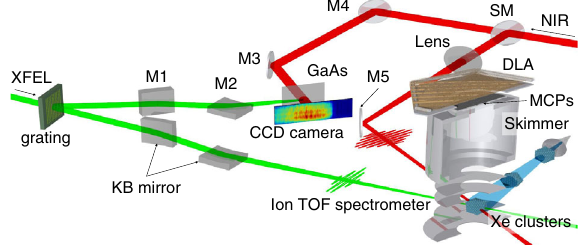
FIG. 3. Schematic picture of the XFEL-pump – NIR-probe experiment. The incident XFEL pulse impinges the grating [34], which generates multiple beams. A main part of the XFEL beam is focused on the interaction point by Kirkpatrick-Baez (KB) mirrors. The XFEL pulse [5.5 keV, < 10 fs (FWHM), 30 μ J = μ m 2 ] and the NIR laser pulse [800 nm, 32 fs (FWHM), 15 nJ = μ m 2 ] illuminate the Xe clusters ( h N i ¼ 5000 atoms) directed to the interaction point through a skimmer. The ion time-of-flight (TOF) spectrometer accelerates the produced ions, and the position sensitive detector, constructed with microchan- nel plates (MCPs) and a delay-line anode (DLA), detects them. The different ion charges are clearly separated in the time-of- flight spectra. The other parts of the XFEL and NIR laser illuminate single crystals from gallium arsenide (GaAs) serving as targets for the arrival timing monitor [34]. The CCD camera records the spatial modulation of the optical transmittance of the NIR laser in order to determine the accurate time delay of the NIR-probe pulse with respect to the XFEL-pump pulse. M1 and M2 are mirrors for the XFEL beam, M3 – M5 are mirrors for the NIR laser, and SM is a split mirror for the NIR